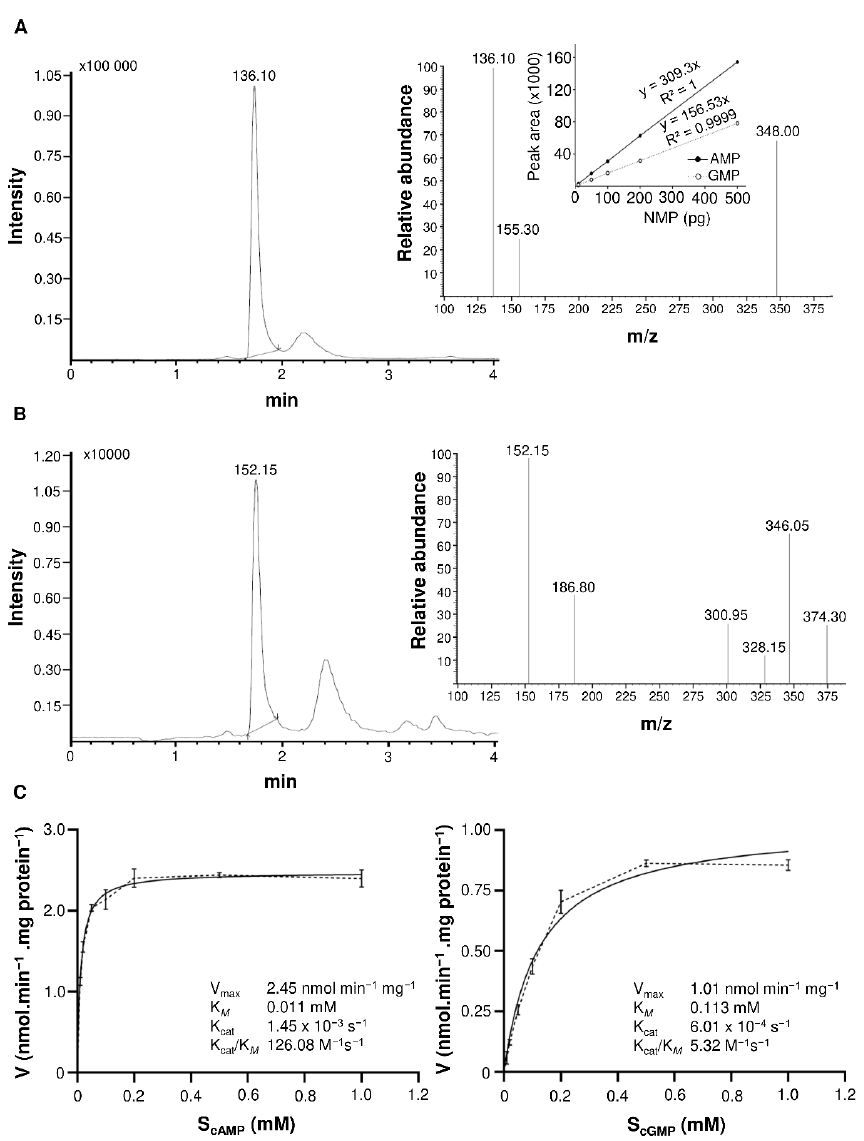
1.01-nmol GMP min − 1 mg protein − 1 , and the affinity for cGMP was almost 10-fold lower fold lower (K M of 0.1133 mM). The activities obtained by BDPDE1 were somewhat lower compared with those of the A. thaliana ortholog (V max 58.22-nmol min − 1 mg protein − 1 and K M 0.0258 mM) [16] and comparable to the A. thaliana K + transporter ATKUP5 (V max 1.17-nmol AMP min − 1 mg protein − 1 and K M 0.0053 mM) [17], which also contained domain.